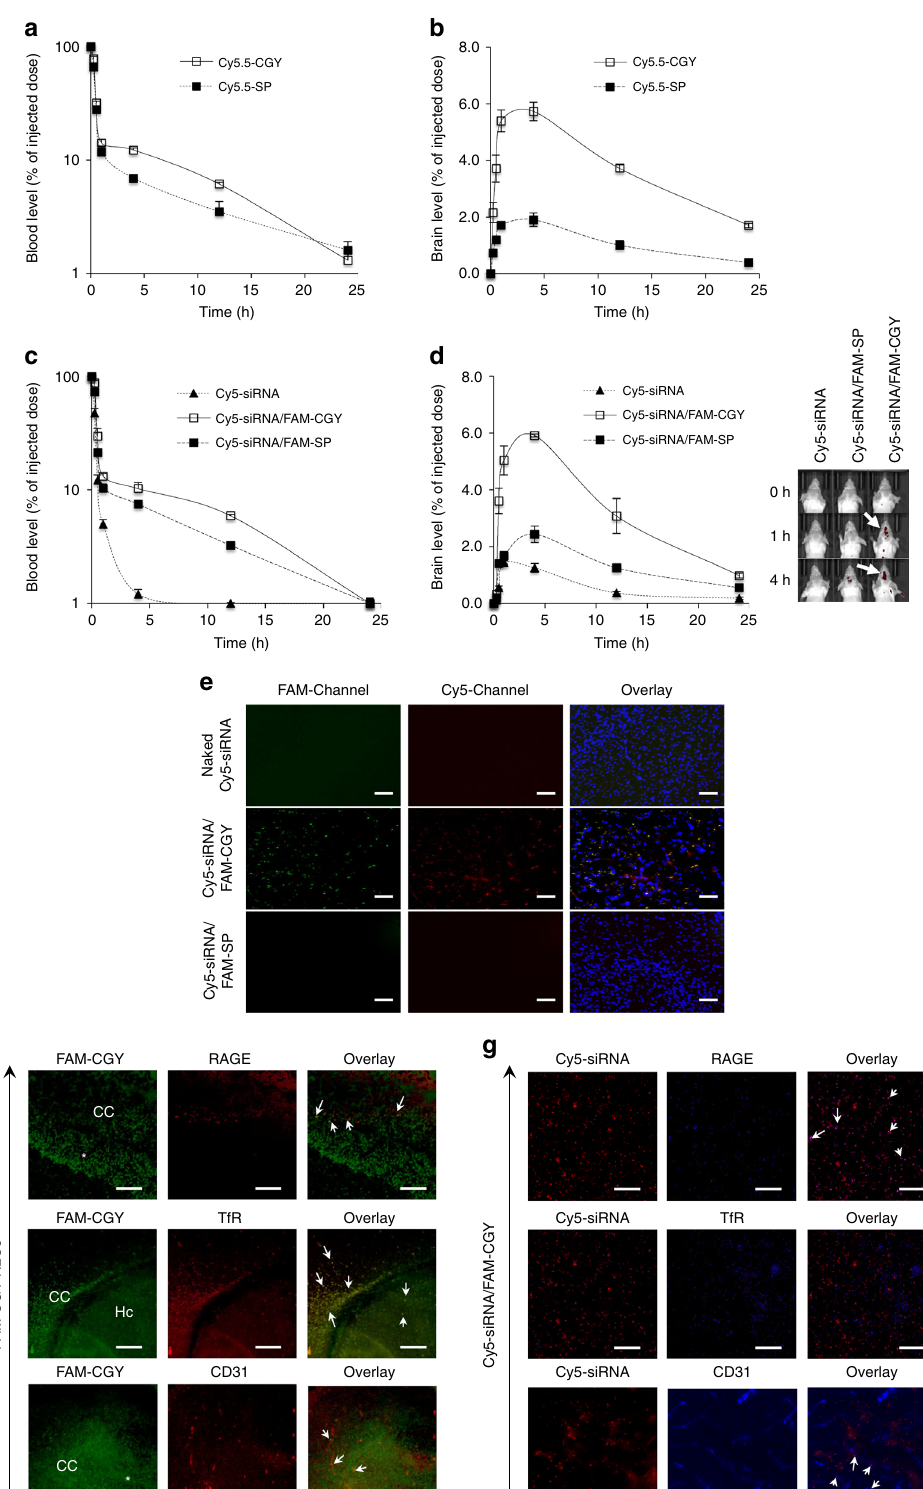
labelled scrambled peptide (Table 1) poorly accumulates in the Next, we evaluated whether nano fi bres formed between FAM- brain (Fig. 4b) thus con fi rming FAM-CGY speci fi city in brain CGY and a Cy5-labelled siRNA can also target the brain and targeting. In contrast to our observations, the best reported active deliver siRNA. The blood clearance pro fi le of nano fi bres mirrors targeting with an optimised transferrin-decorated nanoparticle that of native NLCs (Fig. 4c). The results also show considerable formulation (a system ascribed with high target binding avidity) siRNA deposition to the brain (observable within an hour of has only delivered 1% of intravenously injected dose to the brain injection and peaks by 4 h), which was not achievable on injection at 8 h post injection 12 . of naked siRNA or siRNA in combination with the FAM-labelled NATURE COMMUNICATIONS| (2019) 10:4635